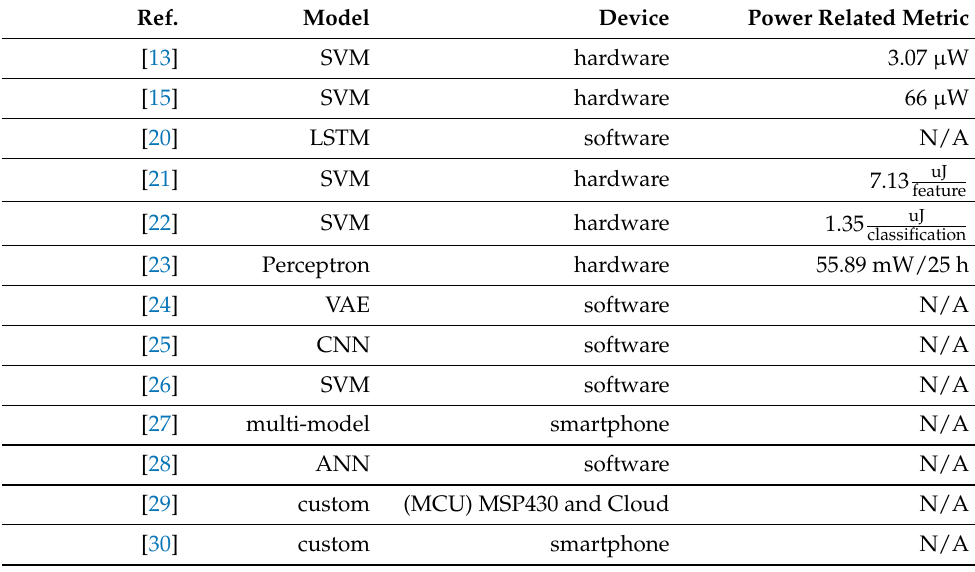
Table 1. Performance summary for epileptic seizure prediction